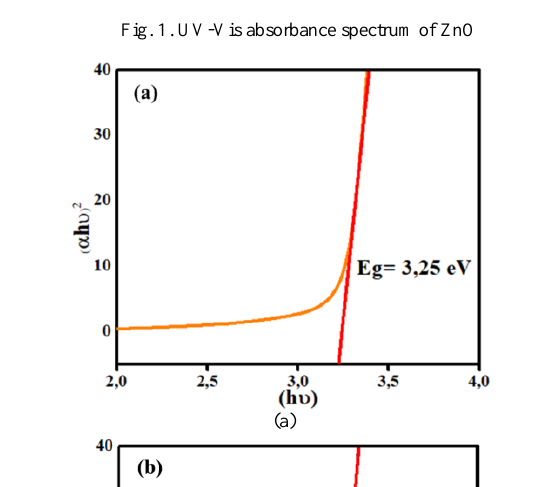
Fig. 1. UV-Vis absorbance spectrum of ZnO